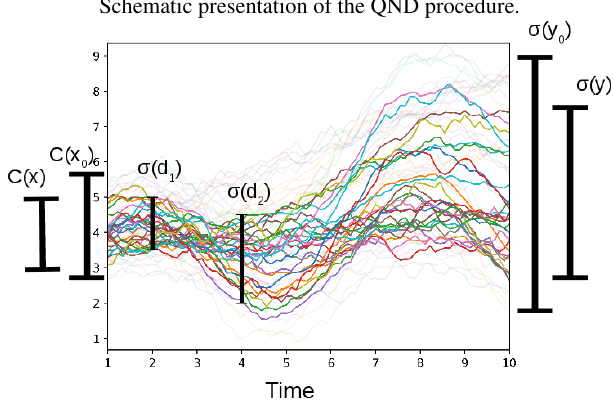
Schematic presentation of the QND procedure.